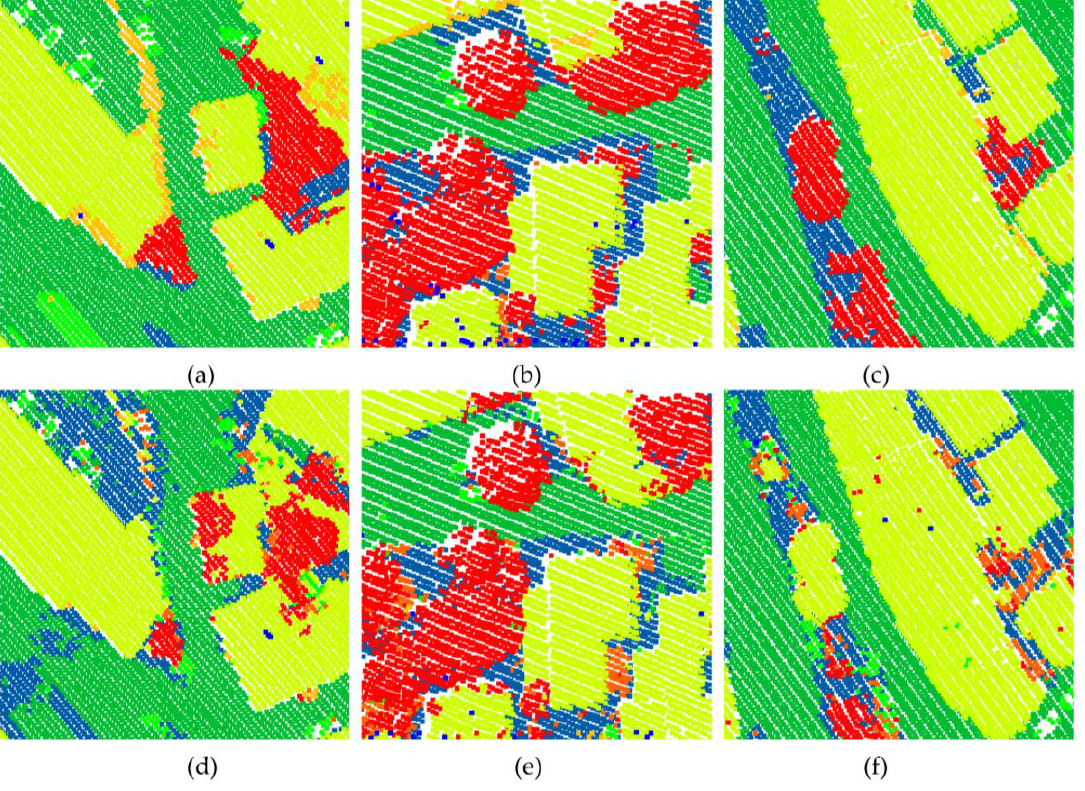
Figure 7. Failure classification. ( a – c ) are the ground results, while ( d – f ) are the corresponding WhuY3